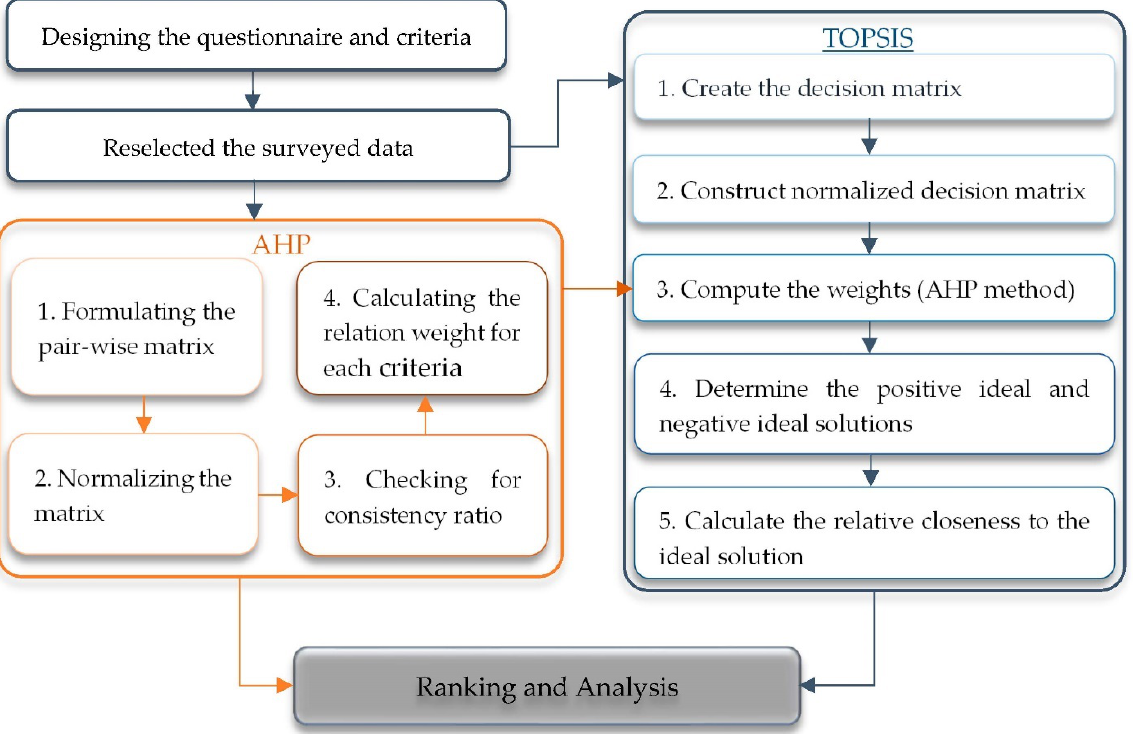
Figure 2. The methodology flowchart .